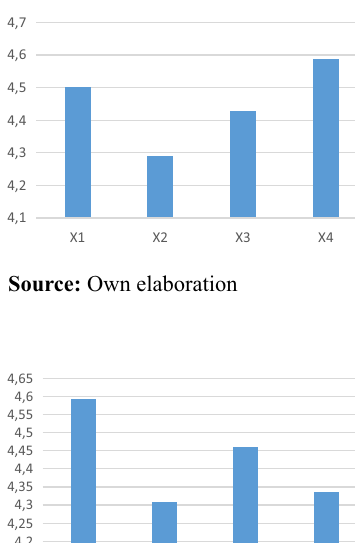
Figure 2. The average score